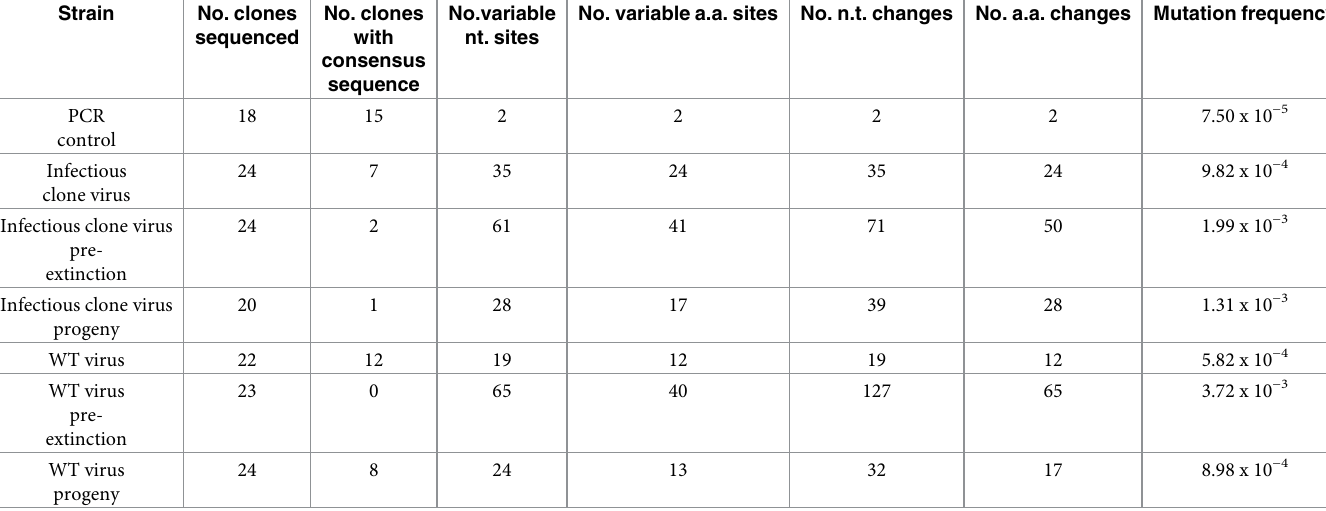
Table 1. Genetic diversities of input, 5FU-treated and their progeny DENV 1 populations. Strain